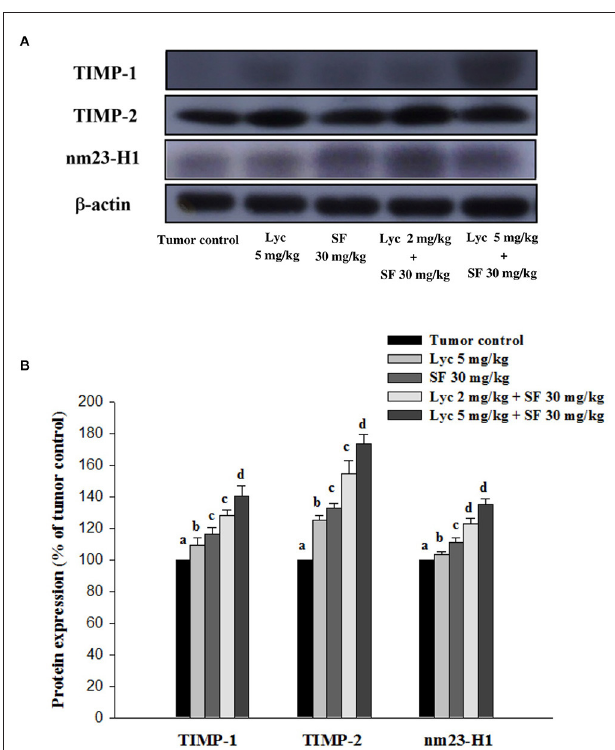
FIGURE 7 | Effects of lycopene (Lyc) alone, sorafenib (SF) alone, or their combination on TIMP-1, TIMP-2 and nm23-H1 protein expression in liver tissues of the C57BL/6 mice xenografted LLC cells. Nine days after tumor cell injection, mice were orally supplemented with SF (30 mg/kg) daily, Lyc (5 mg/kg) twice per week or the combined treatment (mice were supplemented with SF (30 mg/kg) daily, and Lyc (2 and 5 mg/kg) twice per week) for 28 days. (A) Western blot analysis of TIMP-1, TIMP-2, nm23-H1 and -actin. (B) Quantitative results of the protein expressions of TIMP-1, TIMP-2 and nm23-H1. Data are means ± SD, n = 7–8; values not sharing an alphabetic letter are significantly different ( P <